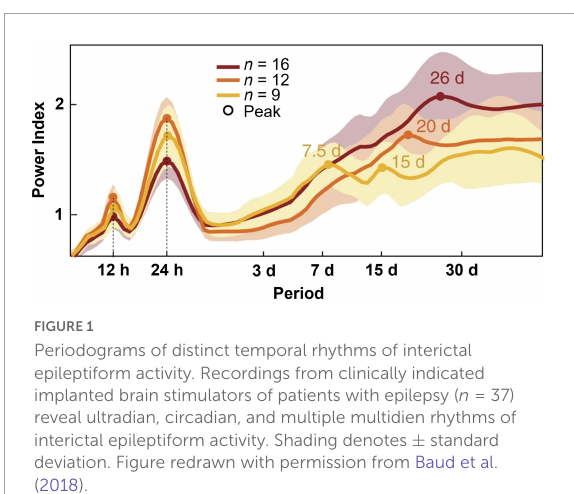
FIGURE1 Periodograms of distinct temporal rhythms of interictal epileptiform activity. Recordings from clinically indicated implanted brain stimulators of patients with epilepsy ( n = 37) reveal ultradian, circadian, and multiple multidien rhythms of interictal epileptiform activity. Shading denotes ± standard deviation. Figure redrawn with permission from Baud et al.